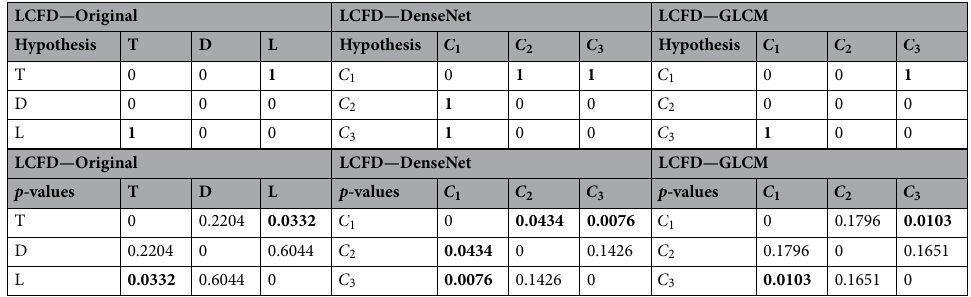
Table 2. K–S test results of the LCFD distributions at the 5 % significance level. P-values highlighted in boldface indicate distribution separability. H = 1 indicates that K–S test rejects the hypothesis.